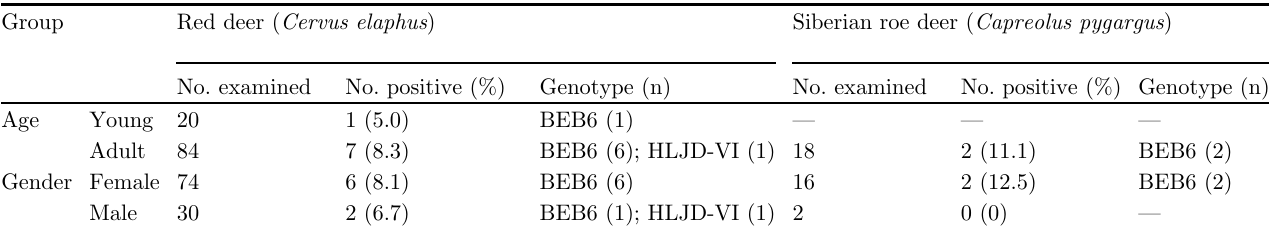
Table 2. Prevalence and genotype distribution of Enterocytozoonbieneusi in red deer and roe deer by age and by gender.